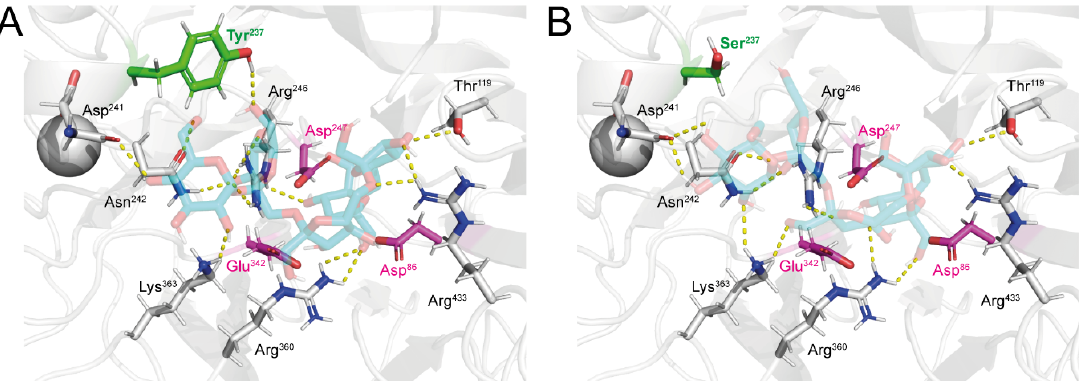
Figure 4. The docking conformation of GF4 into the ( A ) wild-type and ( B ) Y237S mutant LsKK9. The catalytic triad of the enzyme was shown in magenta, and the position of the mutated amino acid residue (Tyr 237 and Ser 237 ) was shown in green.